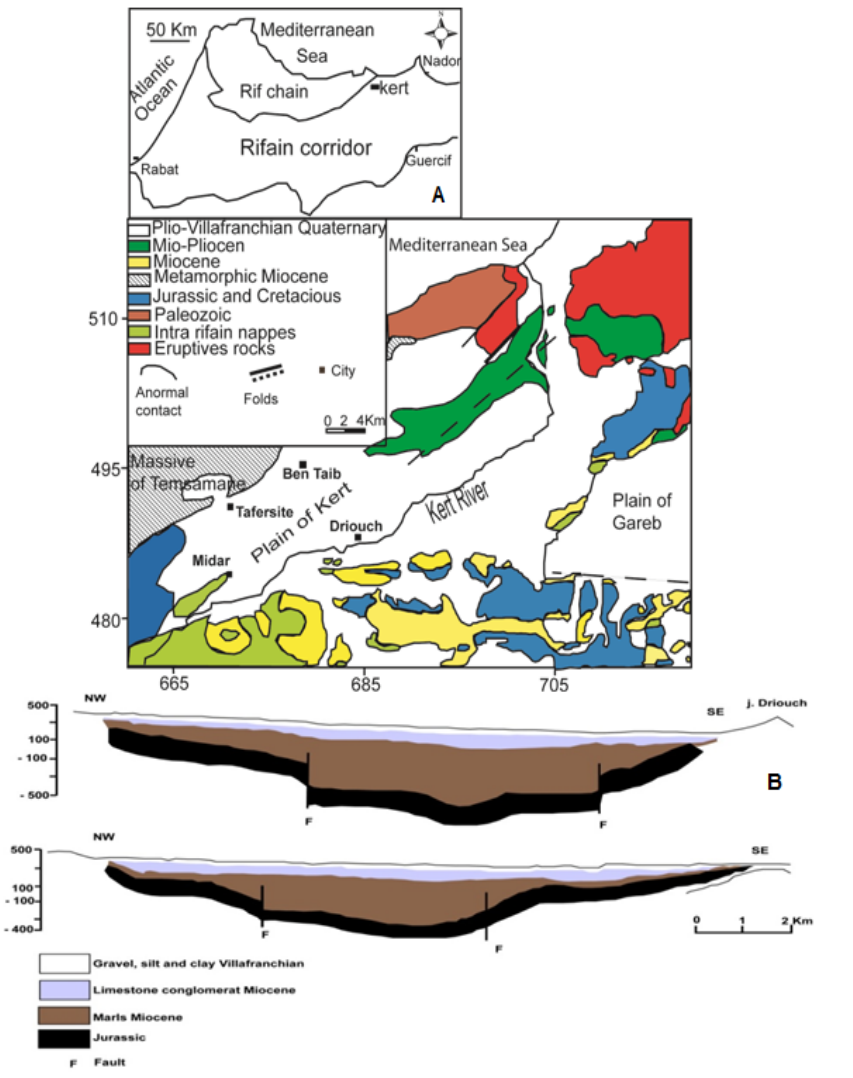
Figure 4. Geological sketch ( A ) and Hydrogeological cross-section of the Kert Plain( B ) [33]. (modified from [34].